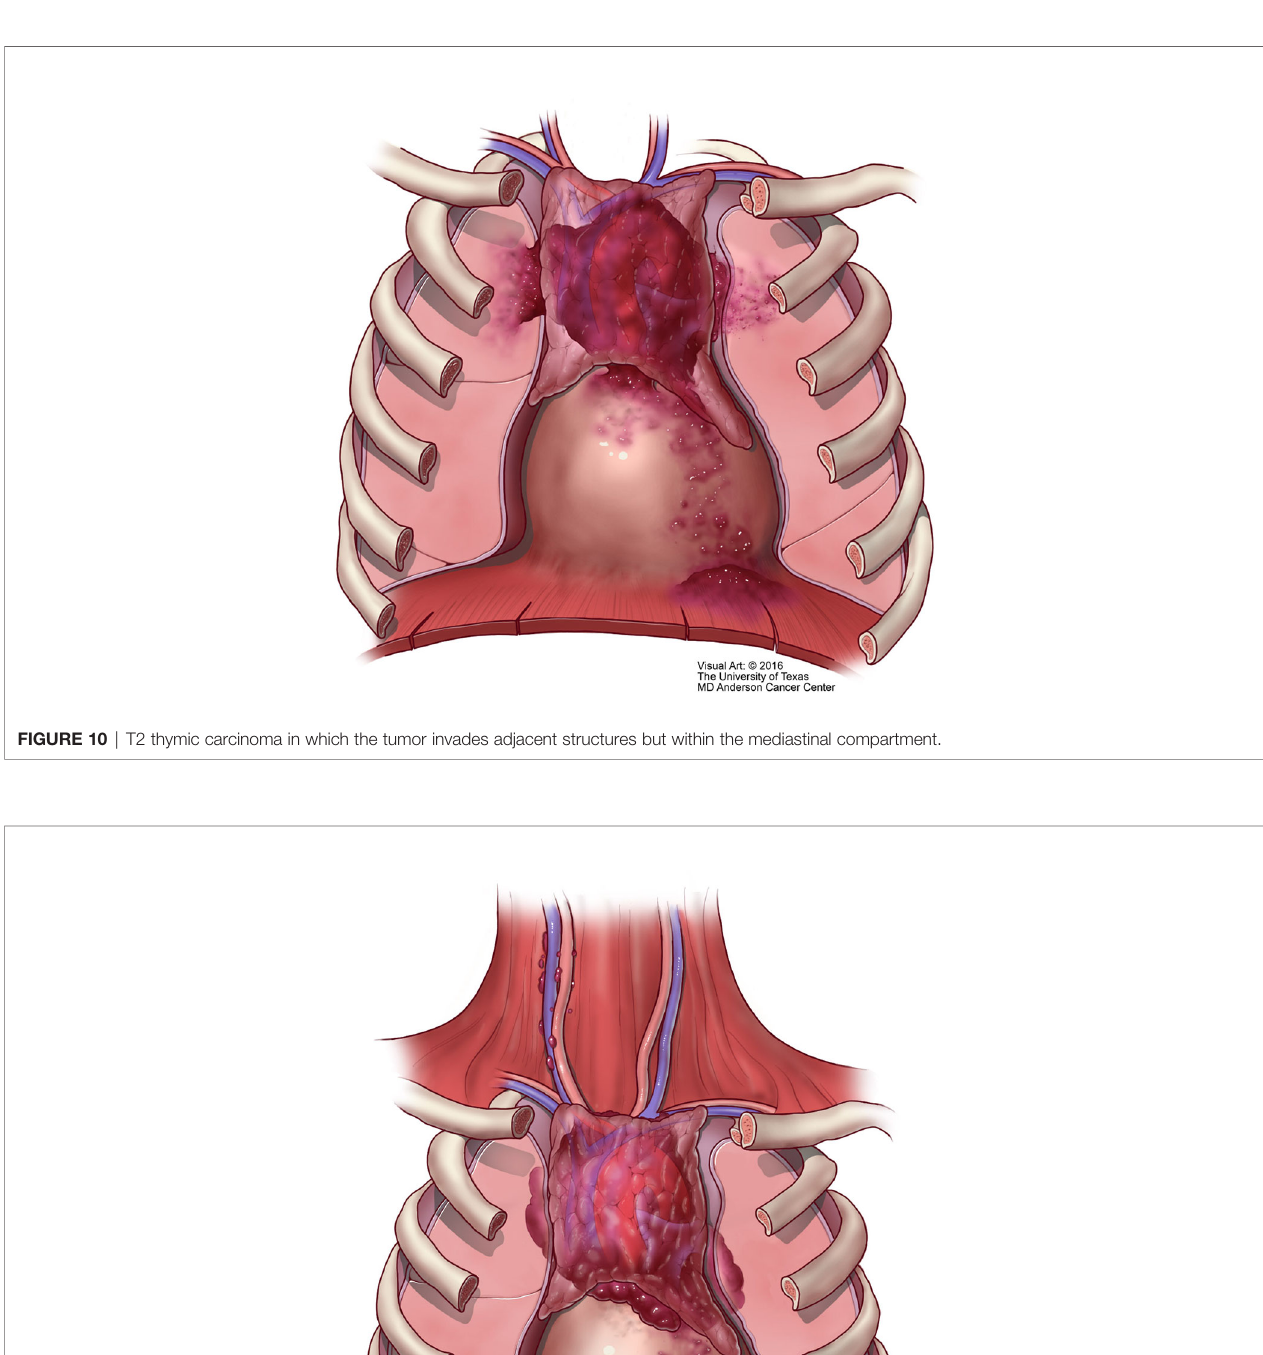
Frontiers in Oncology |